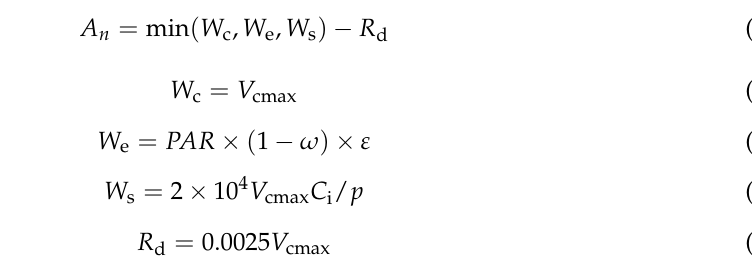
LAI shaded = LAI − LAI